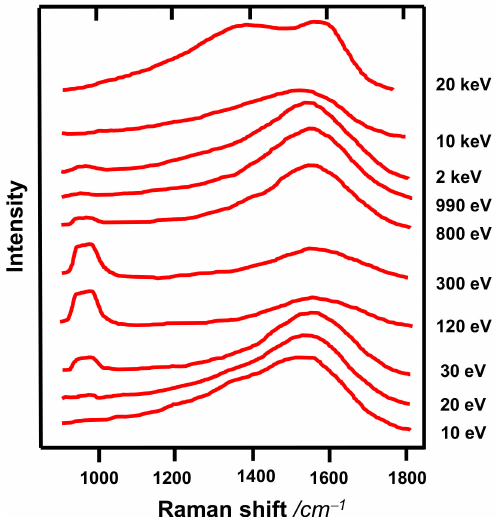
Figure 4. Raman spectrum of carbon films prepared by MSIBD at room temperature with various ion energies (data from